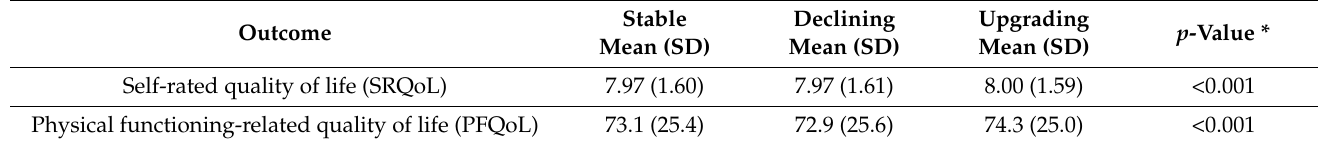
Table 2. Average quality-of-life outcomes by neighborhood change